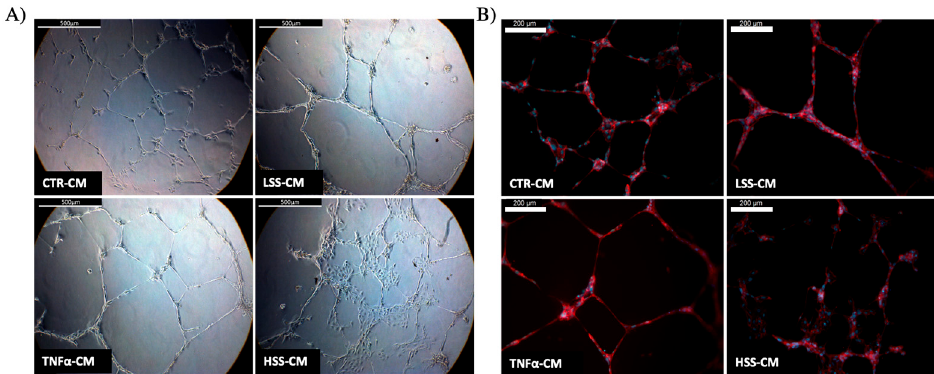
Figure 12. Angiogenesis analysis of tube formation assay at different time points. (* p < 0.05, ** p < 0.01).